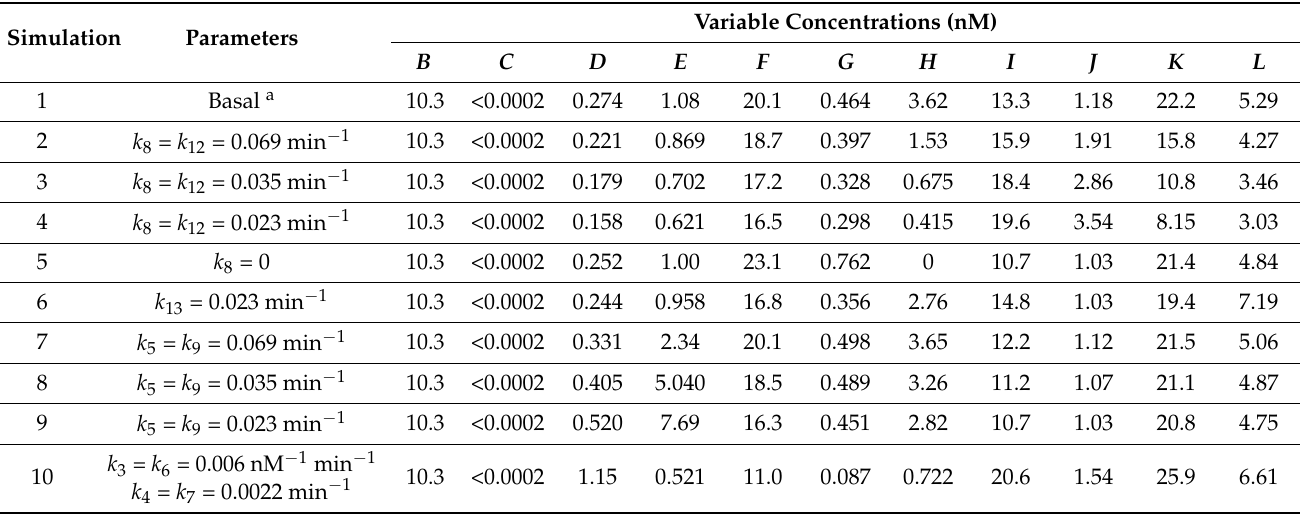
Table 3. TfR model simulations of TfRMAb and Tf transcytosis through the BBB over 120 min after intravenous administra- tion in the Rhesus